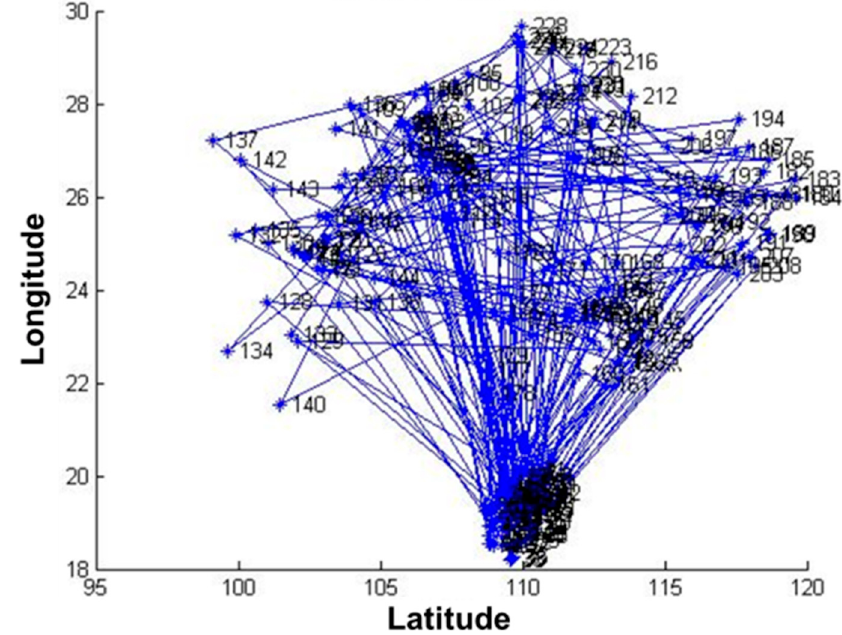
Figure 6. Running results of particle swarm optimization.